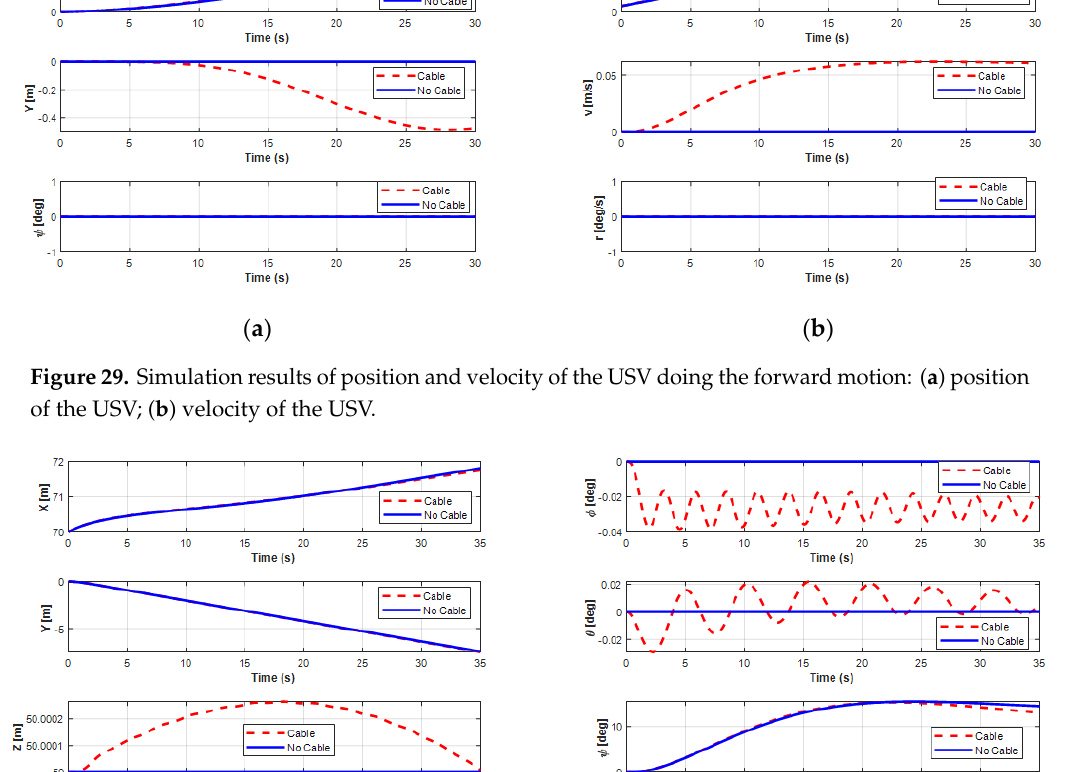
Figure 28. Cable forces and moments effecting to the UUV doing the sideward motion: ( a ) forces of the UC on the UUV; ( b ) moments of the UC on the UUV.